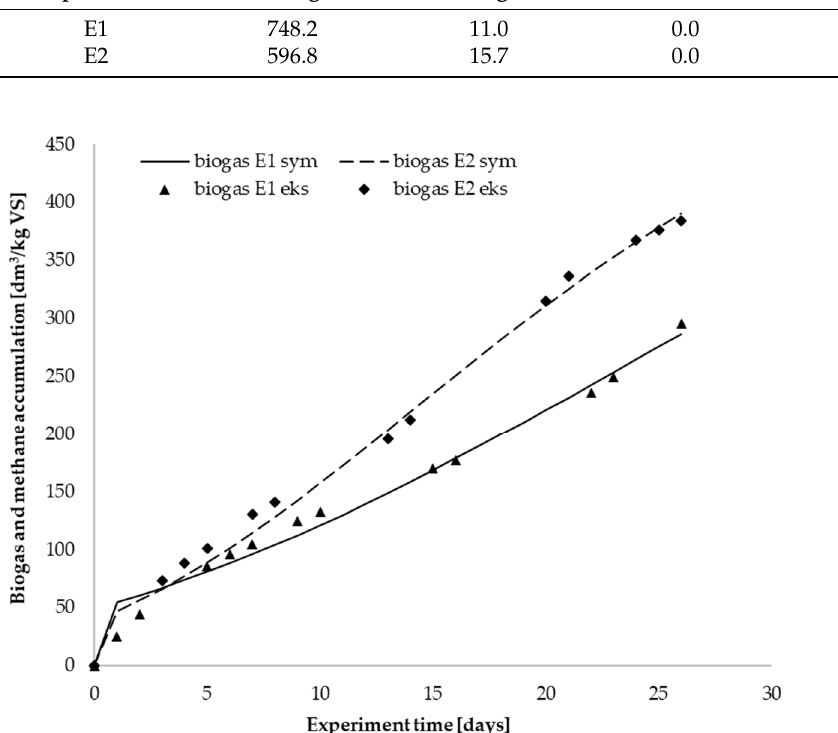
Figure 6. Biogas and methane accumulation curves for simulations and experiments E1 and E2. Table 7. The estimated model parameters and unit simulation of biogas accumulation for 60 days.